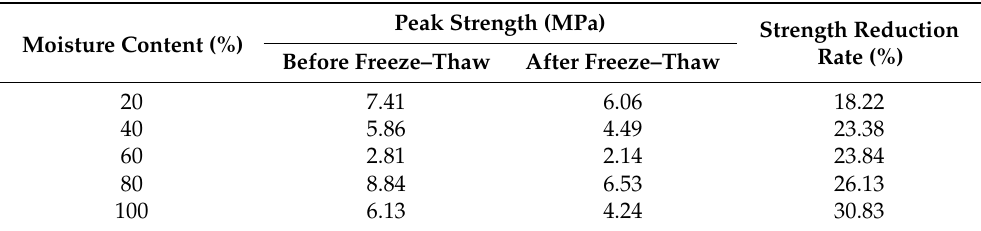
Table 2. Peak strength of the gray brick specimens with different moisture contents before and after freeze–thaw cycles.